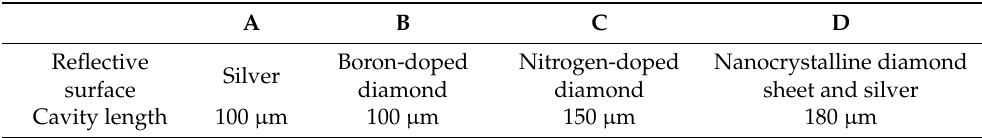
Figure 4. Comparison between the modeled and the measured spectra after removing the Gaussian characteristics and normalization. The cavities were fulfilled with air (n = 1). ( A ) silver mirror d = 100 µm, ( B ) boron-doped diamond film d = 100 µm, ( C ) nitrogen-doped diamond film d = 150 µm and ( D ) nanocrystalline diamond sheet with silver mirror d = 180 µm. Table 2. Label convention of registered